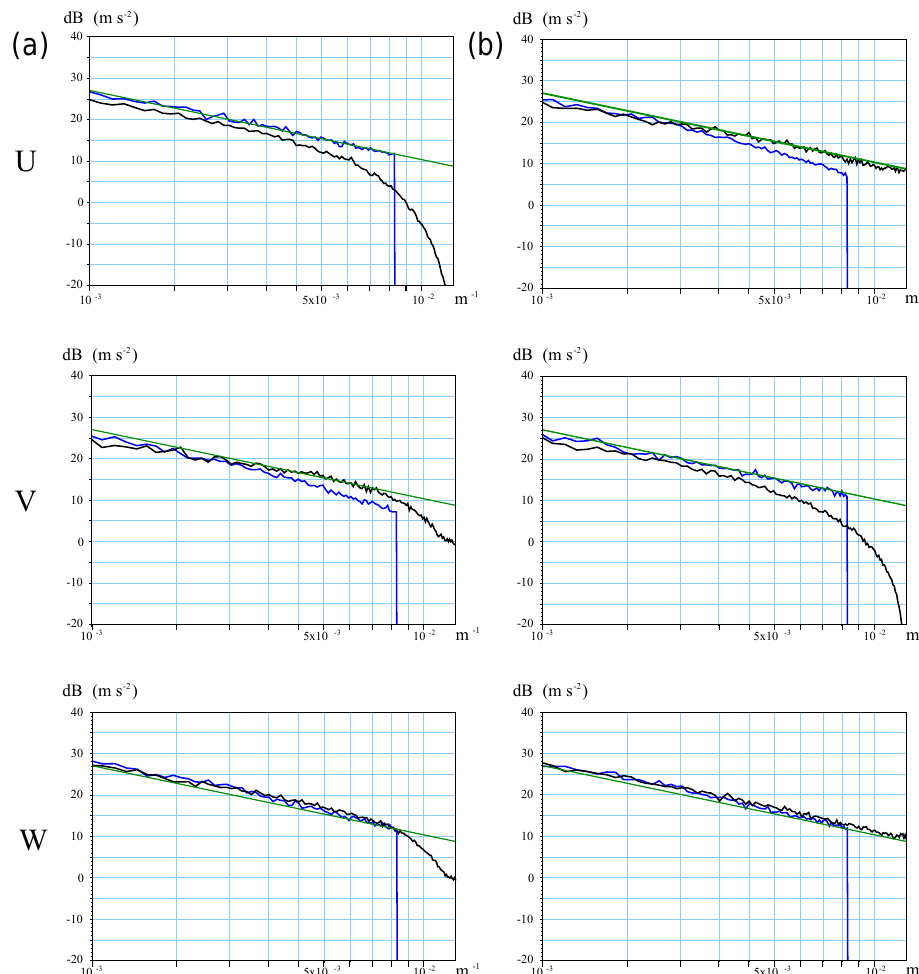
Figure 9. “Row-average” (a) and “Column-average” (b) spatial PSD on the 256 × 256 cells grid of the components of the wind for Meso-NH in black and the LES model of the NCAR in blue. A green line indicates the − 5 / 3 slope according to the K41 theory.